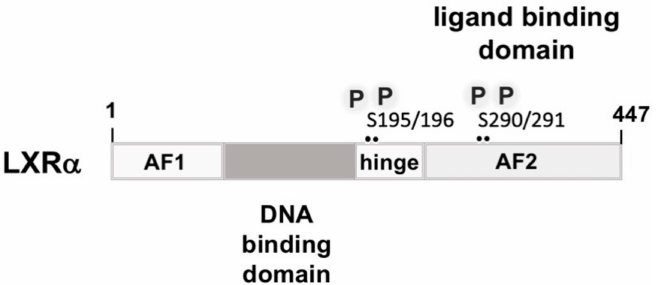
Figure 6. Modular structure of and binding sites of liver X receptor. Liver X receptor α (LXR α ) has the common modular structure of nuclear steroid receptors, containing an N-terminal region with a ligand-independent transcriptional activation function (AF1), a DNA binding domain encompassing two zinc fingers, and a C-terminal ligand-binding domain that is separated from the DNA binding domain by a hinge region. The ligand-binding domain is additionally important for dimerization and transcriptional activation, containing the AF2 transcriptional activation domain. The PKA phosphorylation sites “P” are